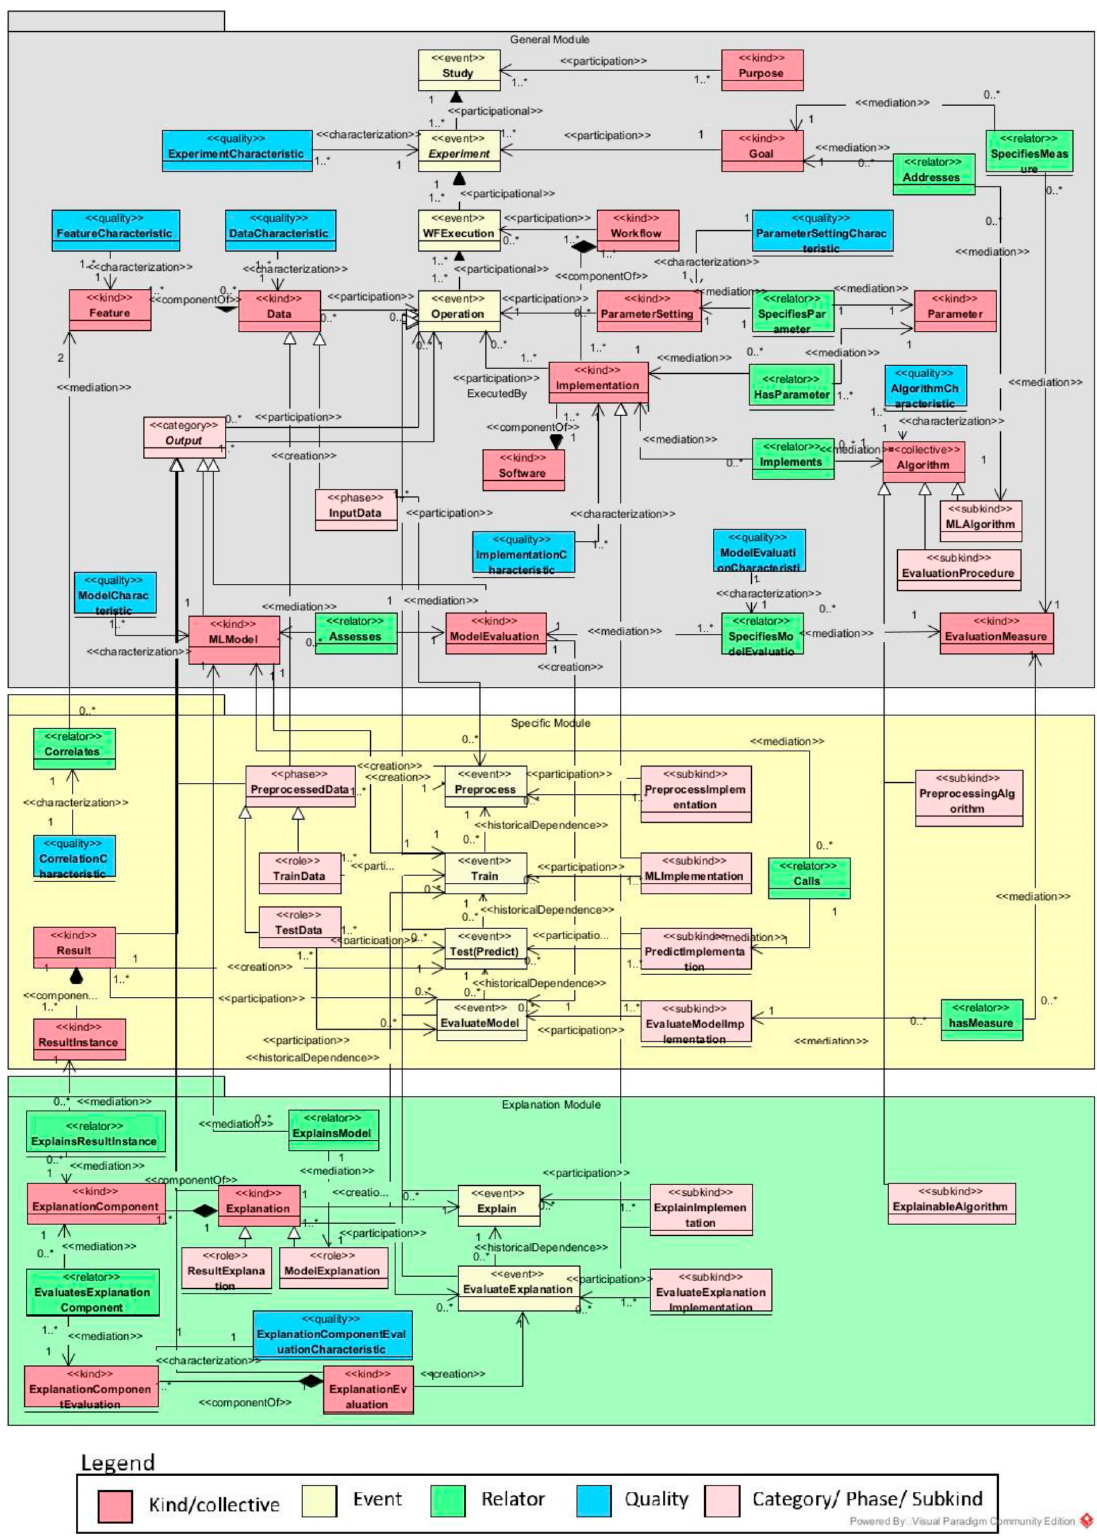
Figure A1. Conceptual model of the ML explanation ontology that is composed of the general ML module (grey region), the specific classification module (yellow region), and the explanation module that represents the post-hoc explanation process (green region).